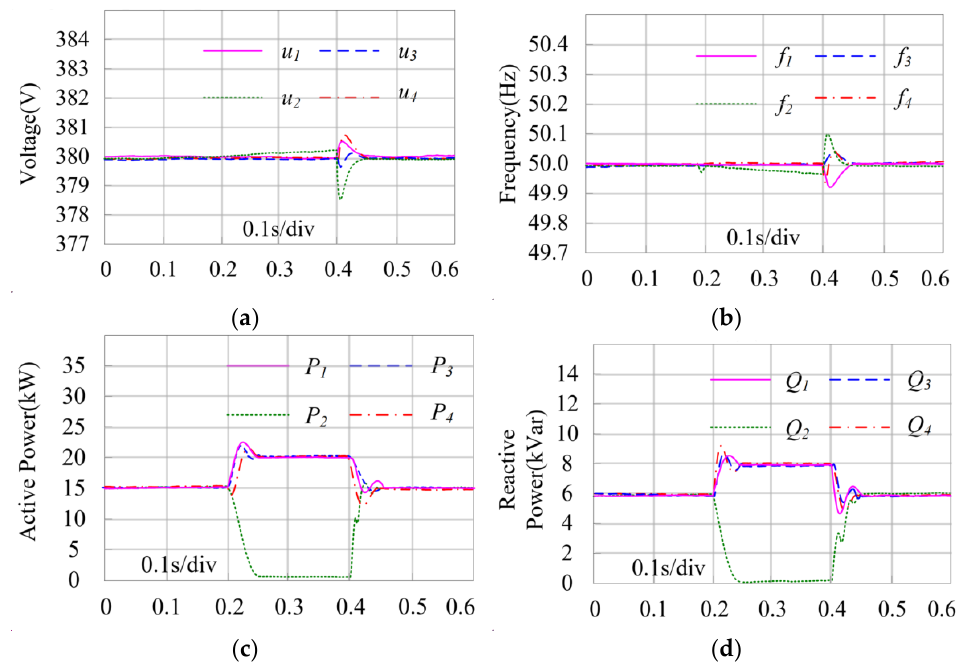
Figure 5. The simulation performance of case study 2. ( a ) voltage amplitude; ( b ) frequency; ( c ) active power; ( d ) reactive power.